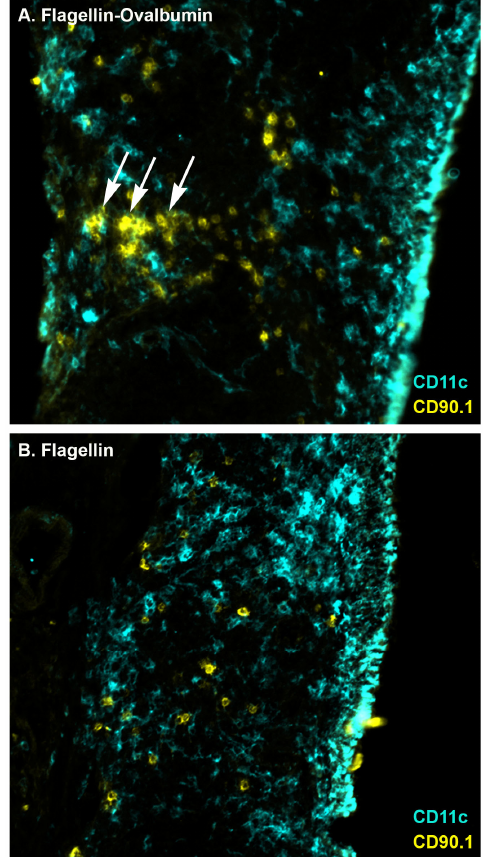
Figure 2. Clustering of OVA-specific CD4 + T cells in the NALT following immunization with flagellin- OVA fusion protein. Mice were i.n. immunized with ( A ) flagellin-ovalbumin (N = 6) or ( B ) flagellin (N = 3). The following day, mice were euthanized, and NALT were harvested. Tissues were frozen, sectioned, and stained to reveal OVA-specific CD90.1 + T cells (yellow) and CD11c+ cells (cyan). Arrows indicate clusters of OVA ‐ specific CD4 + T cells.